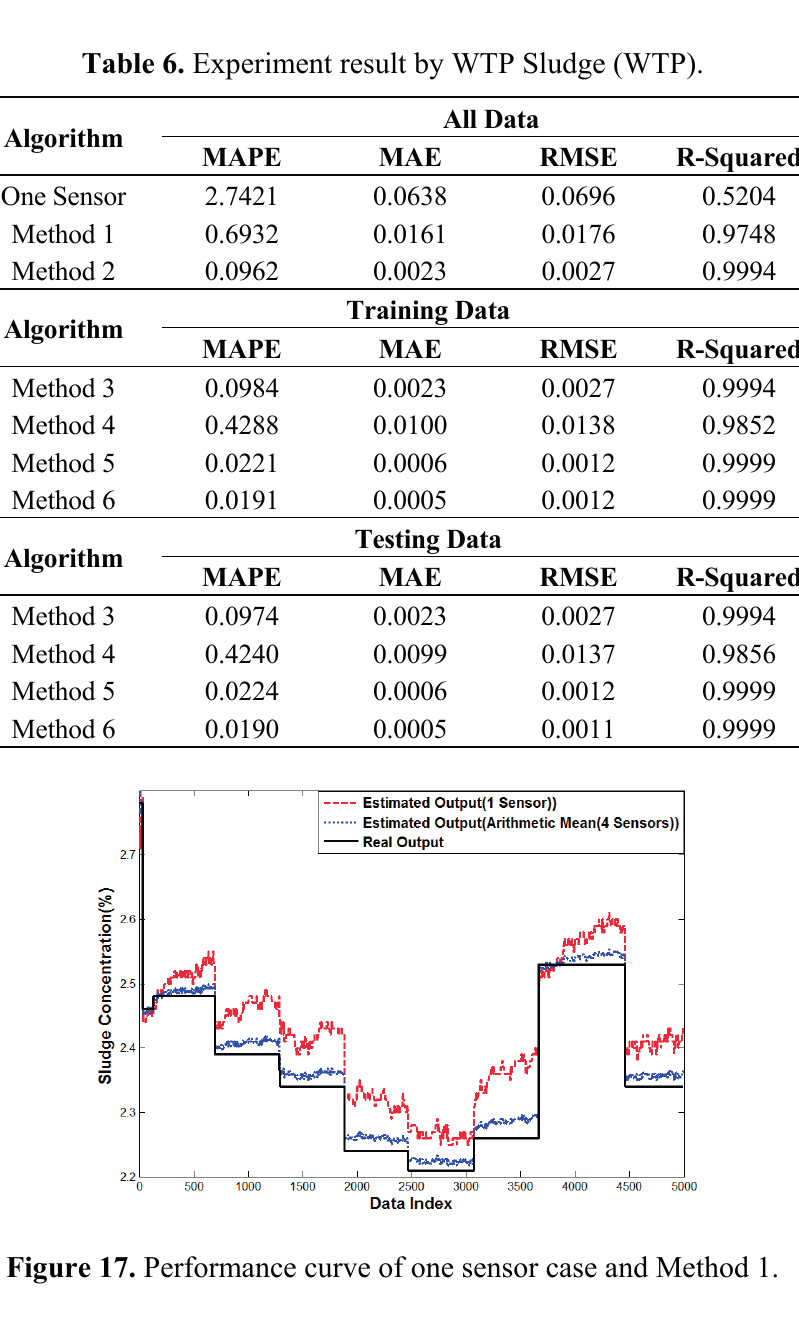
Figure 17. Performance curve of one sensor case and Method 1.